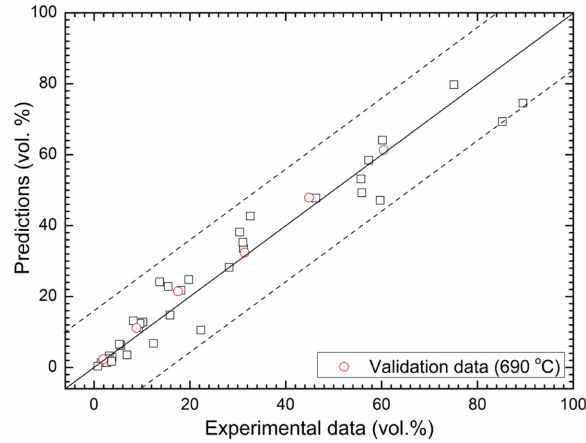
Figure 6. Comparison of predicted and experimental